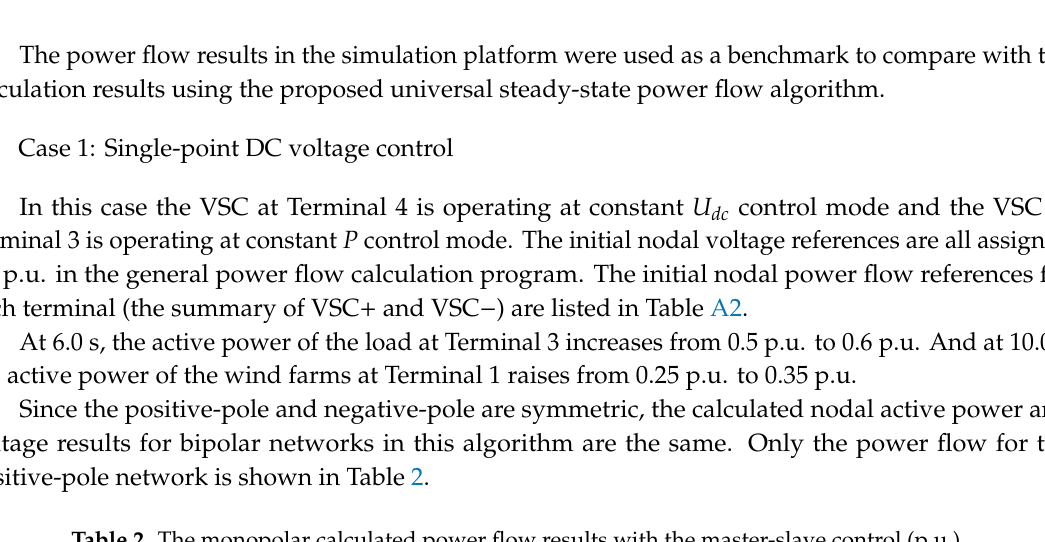
Table 2. The monopolar calculated power flow results with the master-slave control